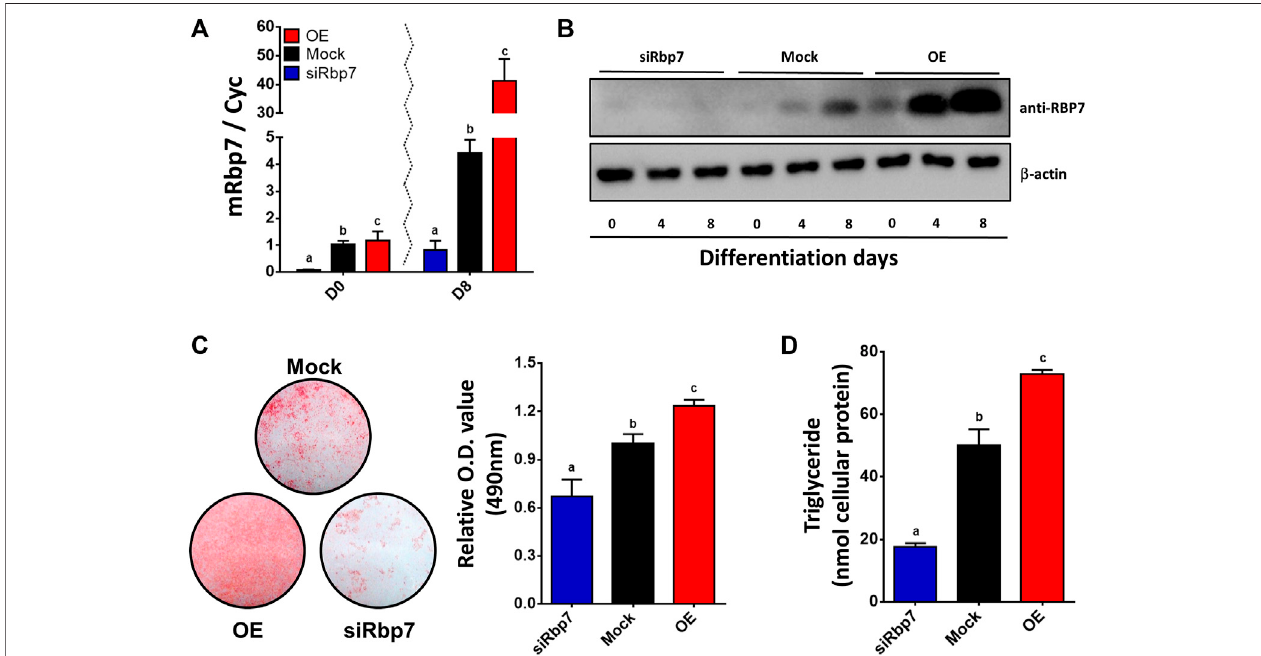
FIGURE 3 | Effect of modulation of Rbp7 expression on adipogenic differentiation of 3T3-L1 cells. (A) Rbp7 expression levels on differentiated 3T3-L1 cells. Red bar: OE group; Black bar: Mock control; Blue bar: siRbp7 group. (B) Western blot analysis of mouse Rbp7. Protein extracts (30 μ g) were loaded to detect protein expression. β -actin was for an internal control. (C) Oil Red O staining. Differentiated 3T3-L1 cells were stained with Oil Red O on day 8 and analyzed the O.D. values by spectrophotometer. (D) Quanti fi cation of triglyceride. Levels of triglyceride in differentiated 3T3-L1 cells were measured on day 8 by ELISA. One-way ANOVA followed by Tukey ’ s multiple comparisons test was used for statistical analysis by the Graphpad PRISM 6.02 program. The bars indicate means ± S.E.M. Statistically signi fi cant differences are marked by the three letters, a, ab, or b ( p < 0.05).